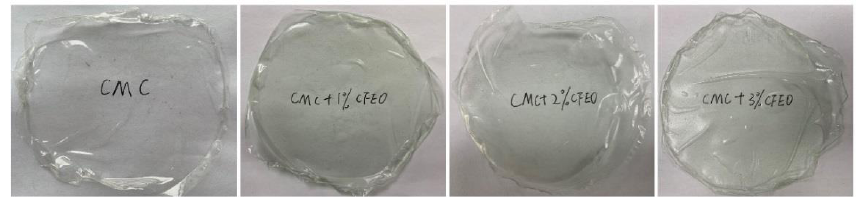
Figure 2. Photographs of films at about 50% RH.